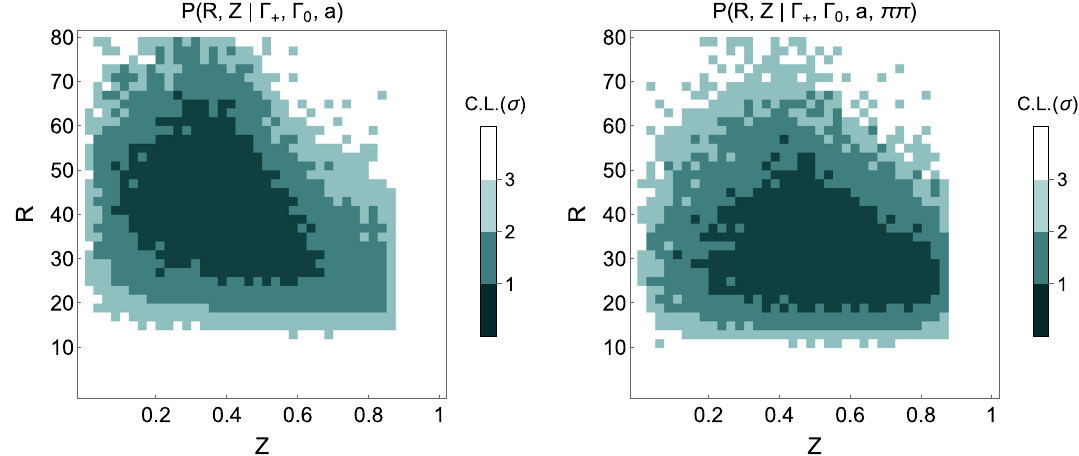
Fig. 6 Probability density P ( R , Z | data ) for R free, X integrated out. Left: η → 3 π data. Right: η → 3 π and ππ scattering data